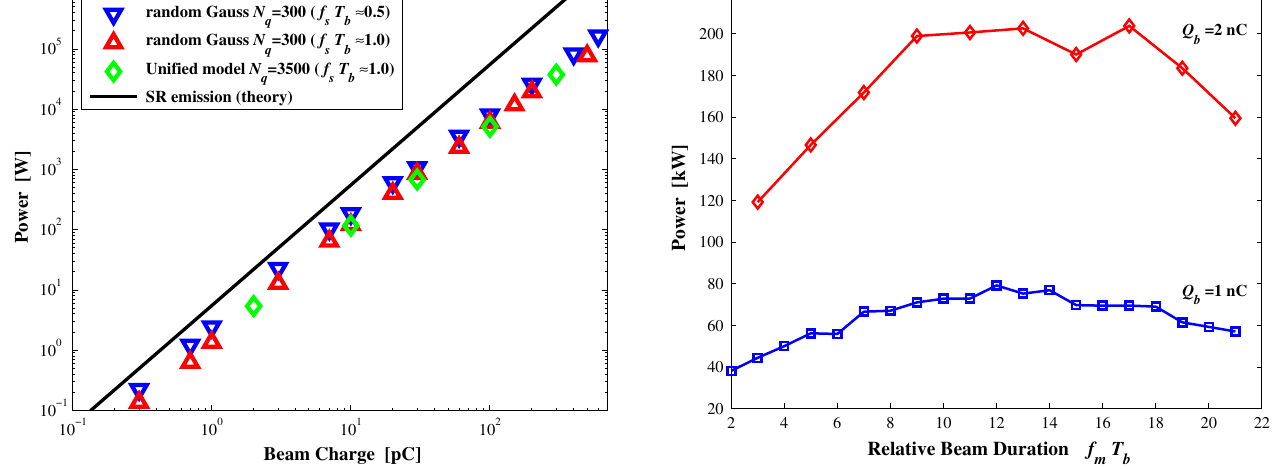
FIG. 5. ECSE FEL radiation power dependence on the beam charge. Random Gauss initial distribution of N q ¼ 300 charged particles, and unified model of electron beam shot noise ( N q ¼ 3500 ) with a Gaussian form beam current density profile.